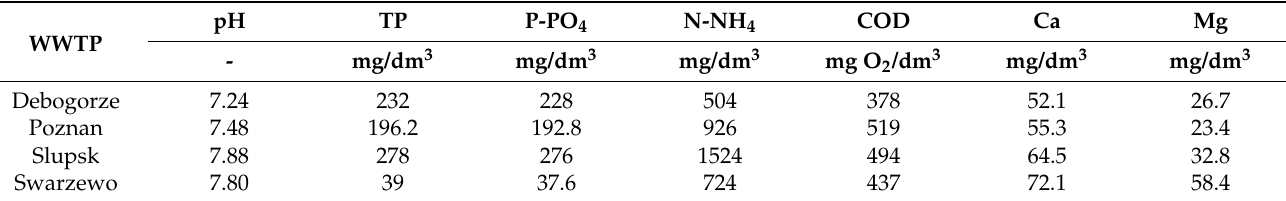
Table 3. Characteristics of raw reject water, average values, n =